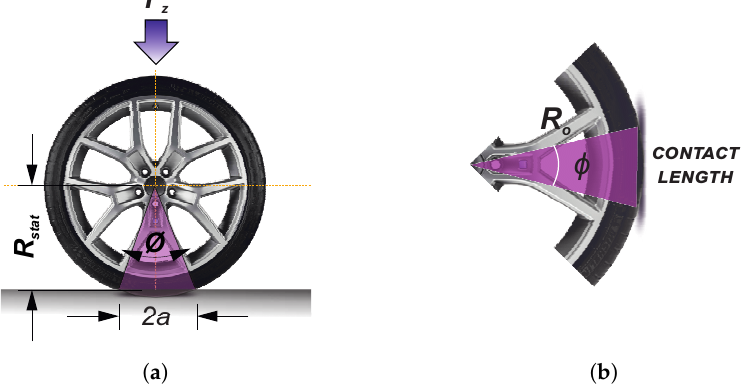
Figure 8. Relationship between contact length and effective rolling radius. ( a ) Calculation of the effective radius according to Rajamani; ( b ) Estimation of the contact